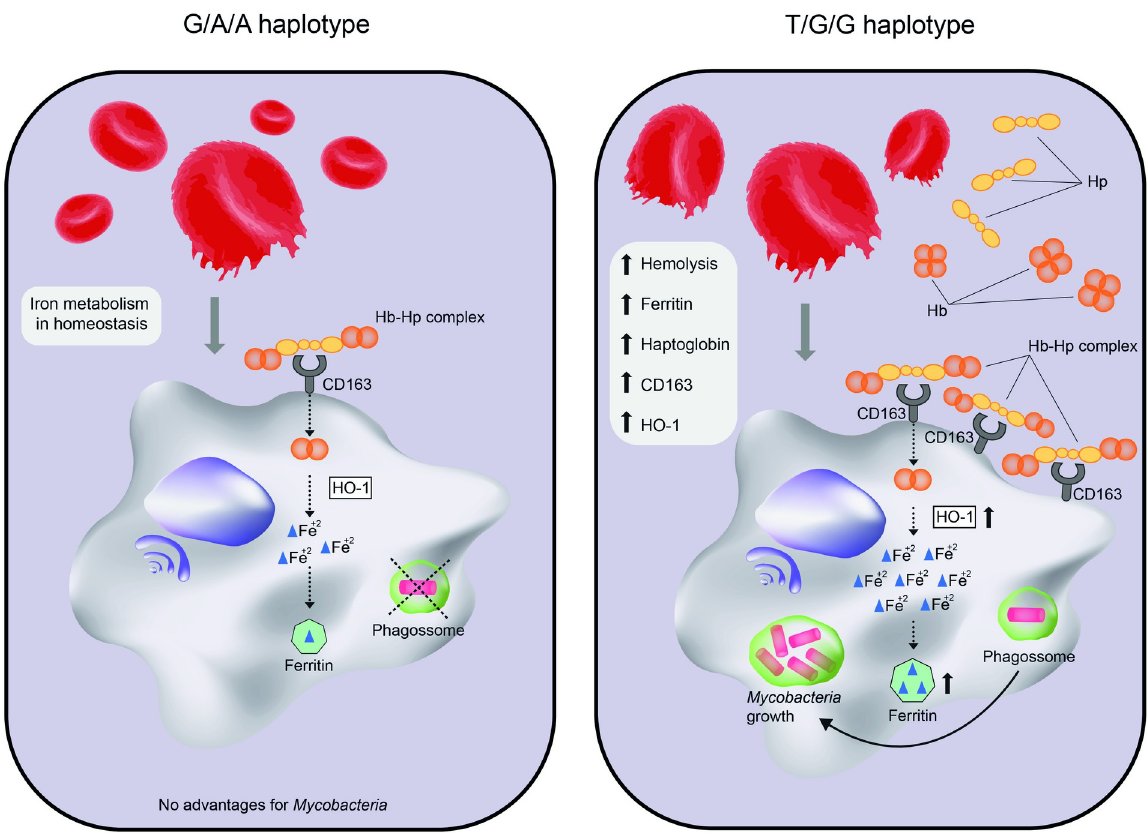
Fig 3. Putative mechanism of mycobacterial infection in the presence of the PKLR risk haplotype. The scheme illustrates the possible pathway that led to increase in ferritin levels and consequently M . leprae persistence inside macrophages. We hypothesized that the RBCs of T/ G/G individuals could speed the hemolysis rate of erythrocytes with low levels of PK. Because of the hemoglobin (Hb) release, haptoglobin (Hp) is increased and the complex Hp-Hb internalizes heme inside macrophages via CD163. Heme-oxigenase 1 (HO-1) cleaves heme into iron, which is stored inside ferritin. Hemolysis is a common mechanism that occur in homeostasis to prevent oxidative stress. However, it can be enhanced in the presence of genetic determinants ( PKLR T/G/G haplotype), leading to a subtle iron overload and a possible advantage for mycobacterial